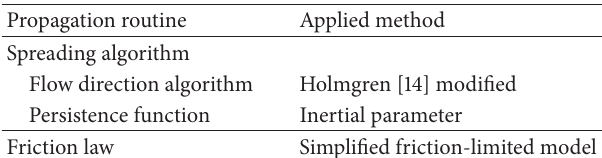
Table 1: Selected landslide disaster algorithms of